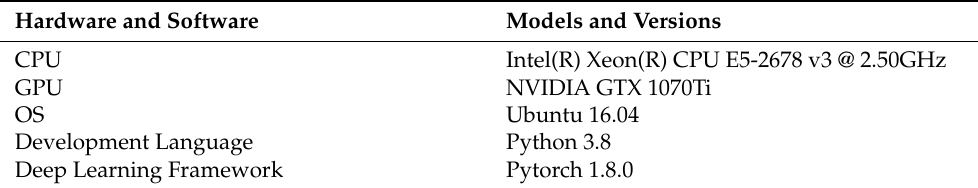
Table 2. Experimental